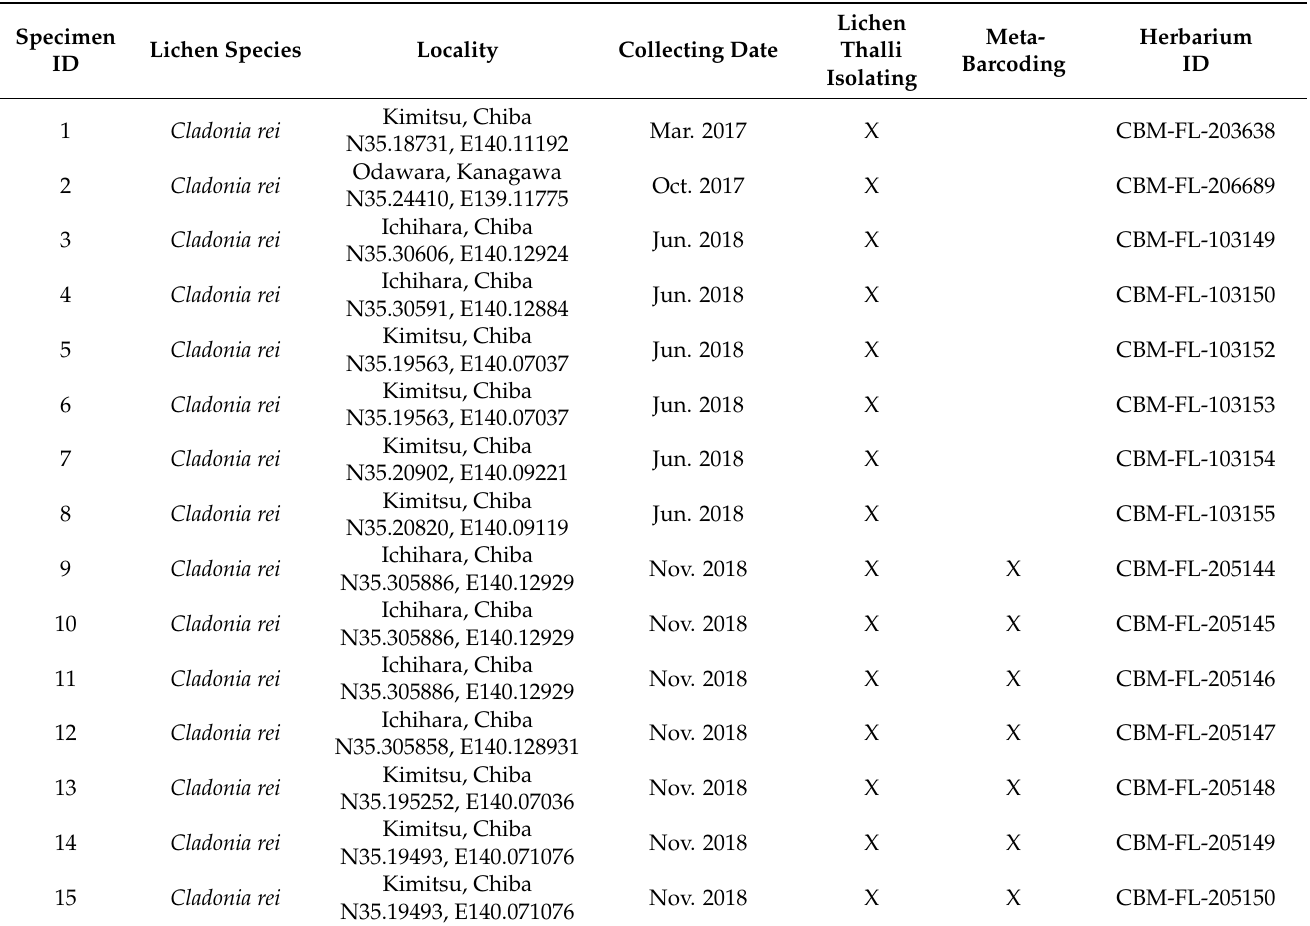
Table 1. Information of the collected specimens of Cladonia rei . “X” indicates the specimens used in the